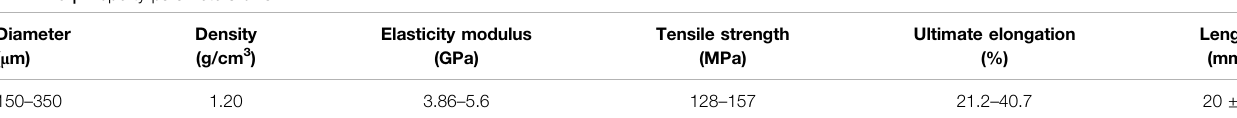
TABLE 5 | Property parameters of CF.